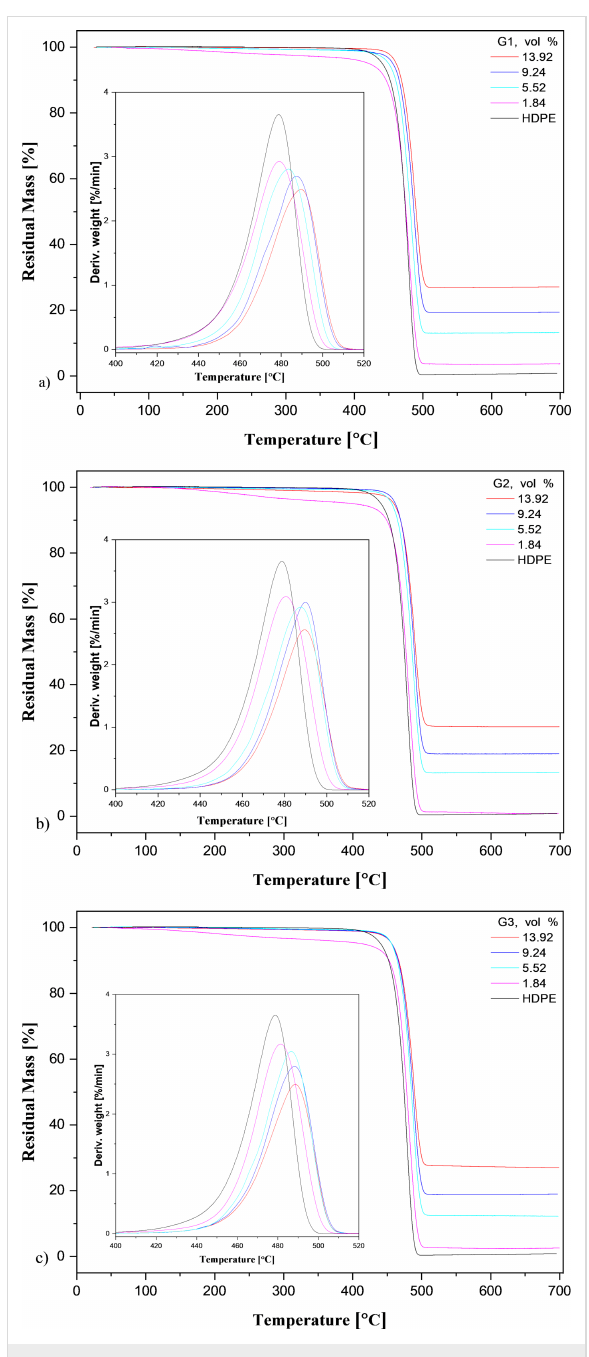
Figure 7: TGA thermographs of the HDPE/GnP nanocomposites with a) G1, b) G2, and c) G3 filler. The insets show derivative thermogravi- metric (DTG)